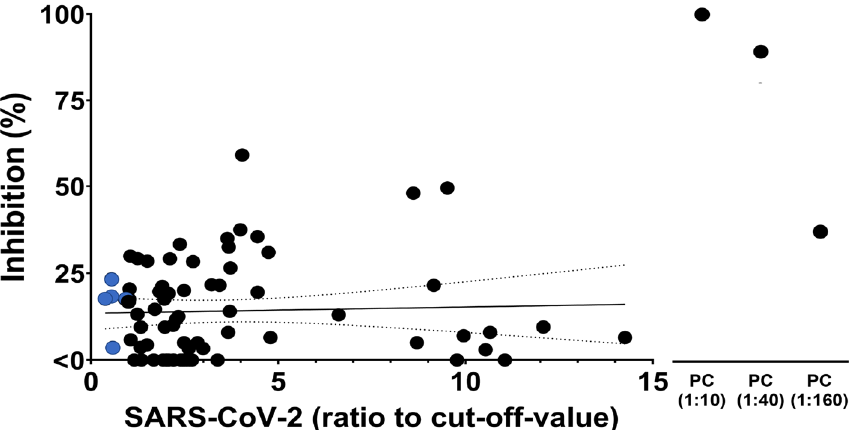
Figure 4. Assessment by PRNT of the neutralizing effect of the SARS-CoV-2 reactive sera. Percentage of inhibition of SARS-CoV-2 infection by reactive sera determined by PRNT in comparison with vehicle control. For each serum, the dot plot shows the correlation between the anti-SARS-CoV-2 reactivity, assessed by ELISA, and the neutralization, assessed by PRNT. A sample from a SARS-CoV-2-infected individual was used as a positive control (PC). SARS-CoV-2 non-reactive samples (negative) are represented with blue circles (n = 5), SARS-CoV-2 reactive samples (positive) are represented with black circles (n = 69). Data are compared by Spearman’s rank correlation